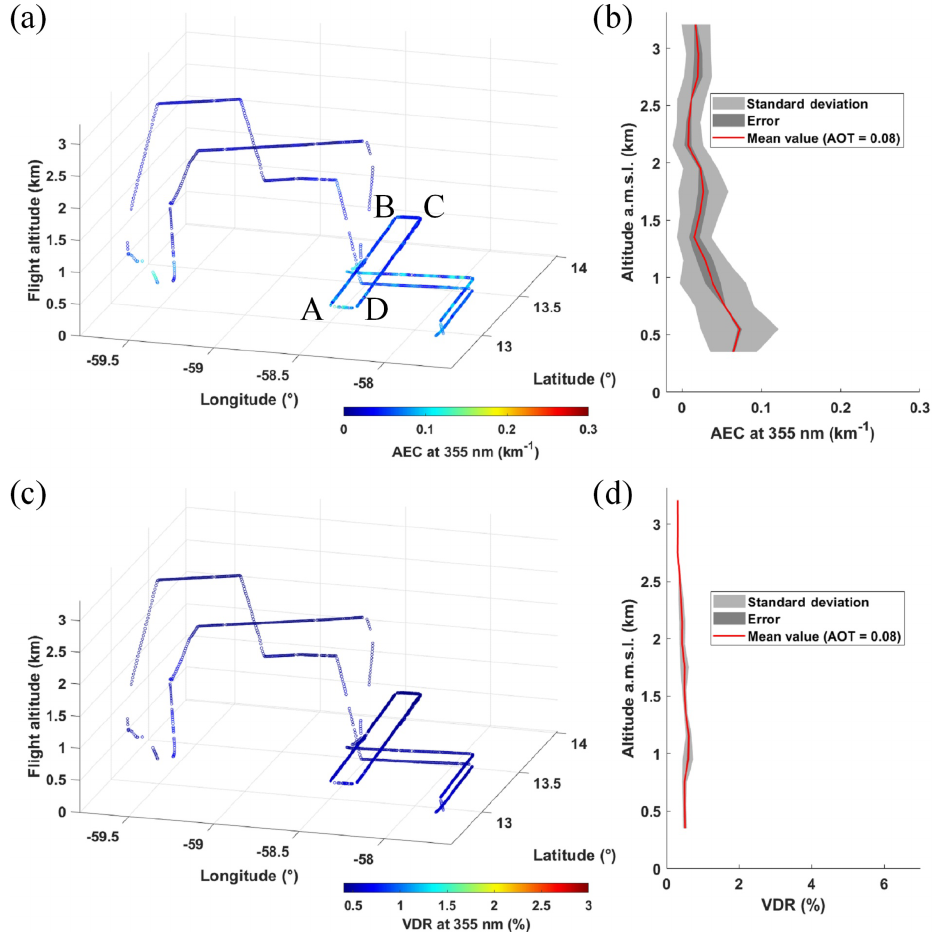
Figure 1. (a) Aerosol extinction coefficient (AEC) derived from ALiAS measurements during the flight F05 on 28 January 2020 at 16:15– 20:50UTC along the horizontal line of slight; (b) corresponding vertical profile of the AEC which shows the spread of measurements via the standard deviation (light-grey area) and the statistical error (dark-grey area). The same types of figures are given for the linear volume depolarization ratio (VDR) in panels (c) and (d) , respectively. The level where a rectangle ABCD has been systematically depicted is highlighted in panel (a)